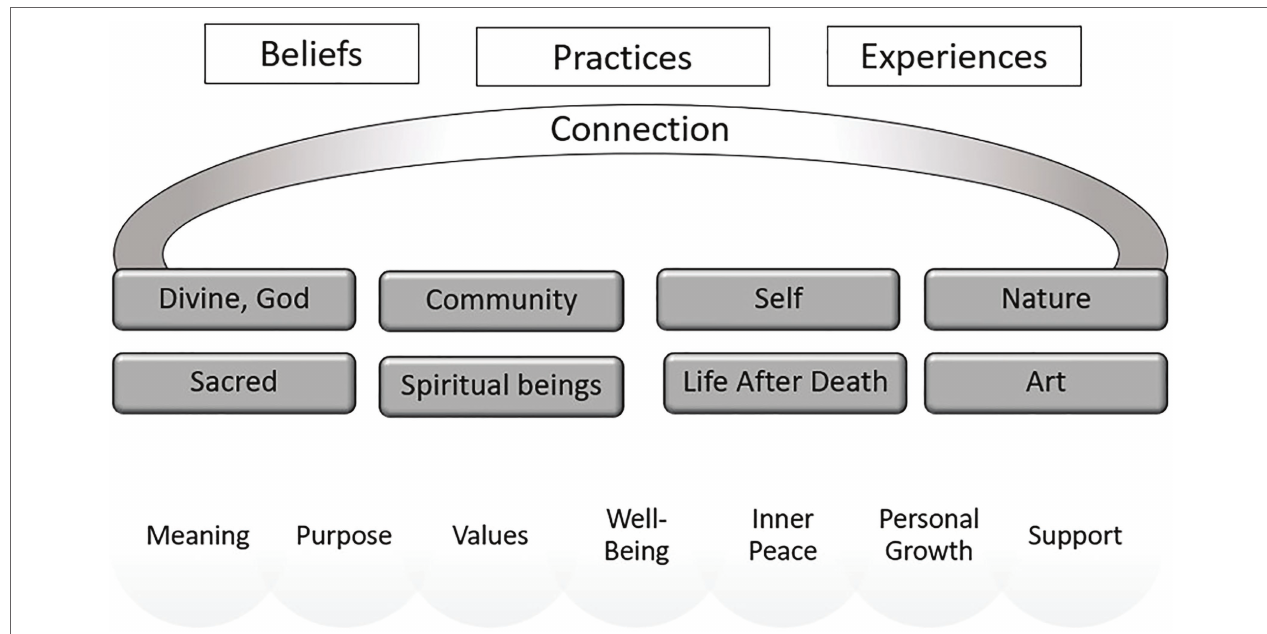
FIGURE 2 | Spirituality framework